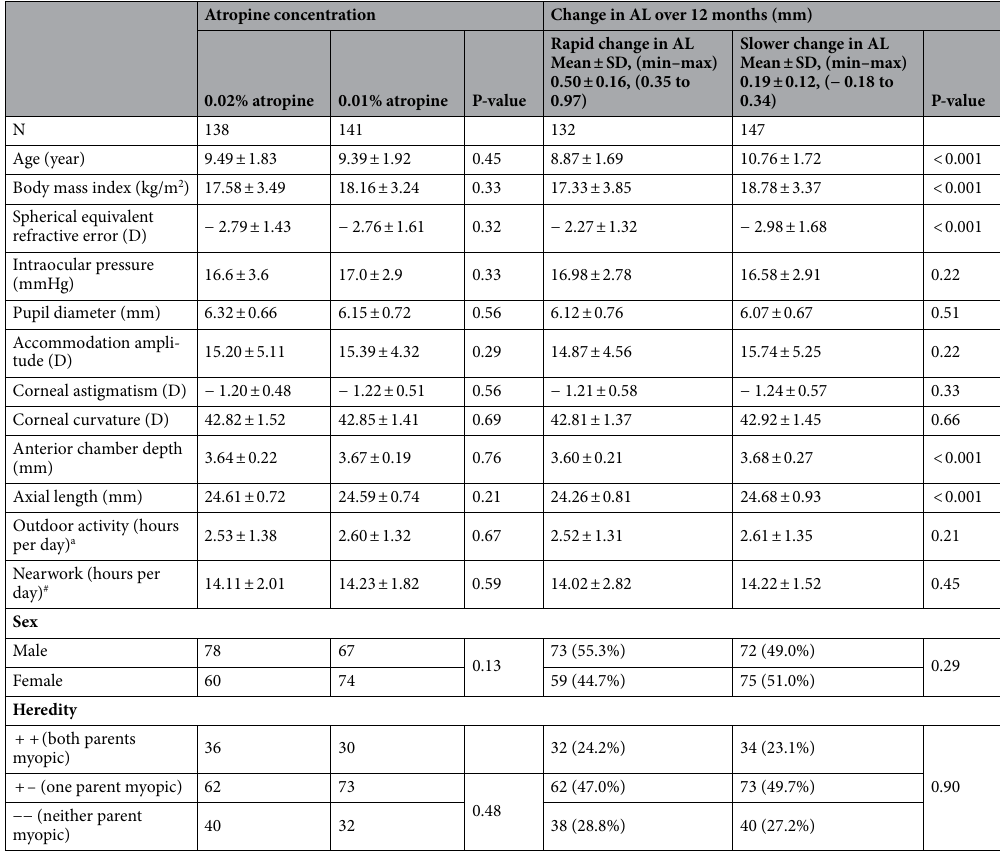
Table 1. Baseline characteristics of participants mean ± SD or n (%). Rapid change in AL defined as > 0.36 mm/year.